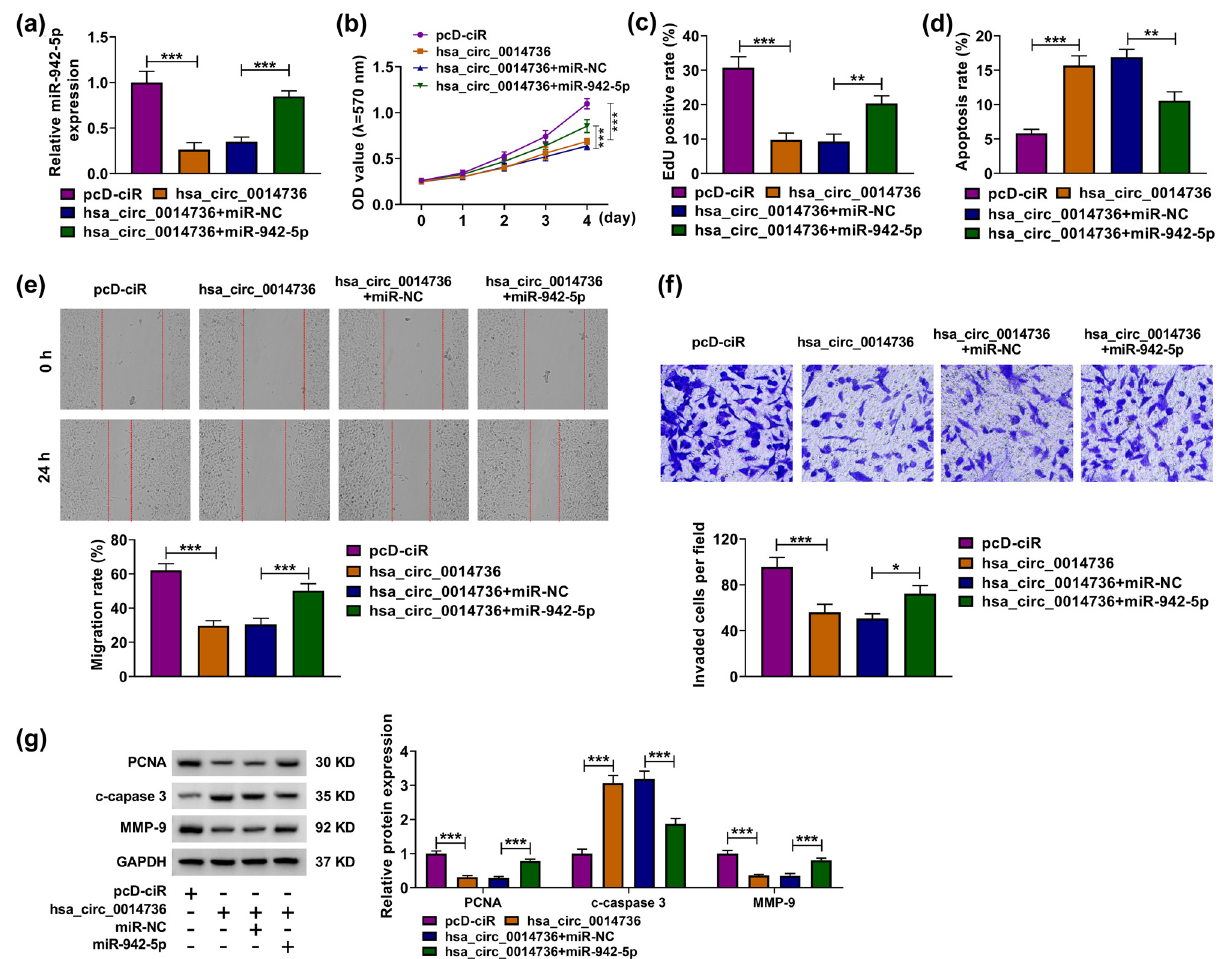
Figure 4: E ff ects of circ_0014736 and miR - 942 - 5p overexpression on the proliferation, migration, invasion, and apoptosis of HTR - 8/SVneo cells. ( a – g ) HTR - 8/SVneo cells were transfected with pcD - ciR, hsa_circ_0014736, hsa_circ_0014736 + miR - NC, or hsa_circ_0014736 + miR - 942 - 5p, and miR - 942 - 5p expression was detected by qRT - PCR ( a ) , cell proliferation by MTT and EdU assays ( b and c ) , cell apoptosis by fl ow cytometry analysis ( d ) ,cellmigration by wound - healing assay ( e ) , cell invasion bytranswell assay ( f ) , andthe proteinexpression of PCNA, c - caspase 3, andMMP - 9by western blot analysis ( g ) . * P < 0.05, ** P < 0.01, and *** P < 0.001. Three independent duplicate tests were performed in each